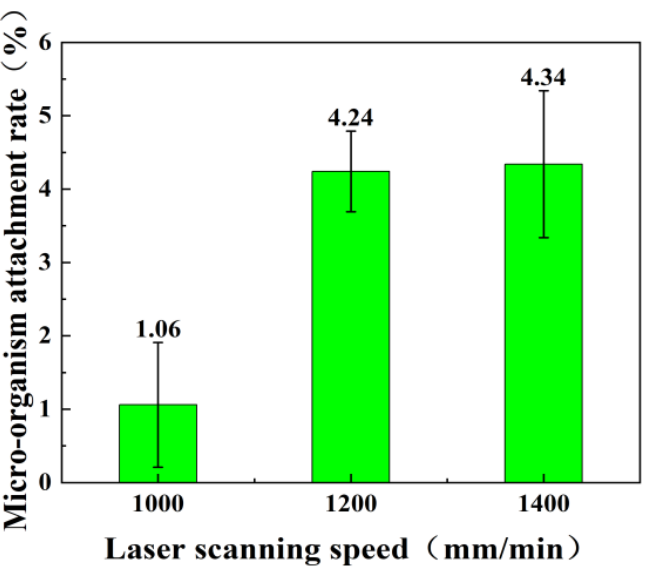
Figure 9. Micro-organism attachment rates of specimens No. 8–10.